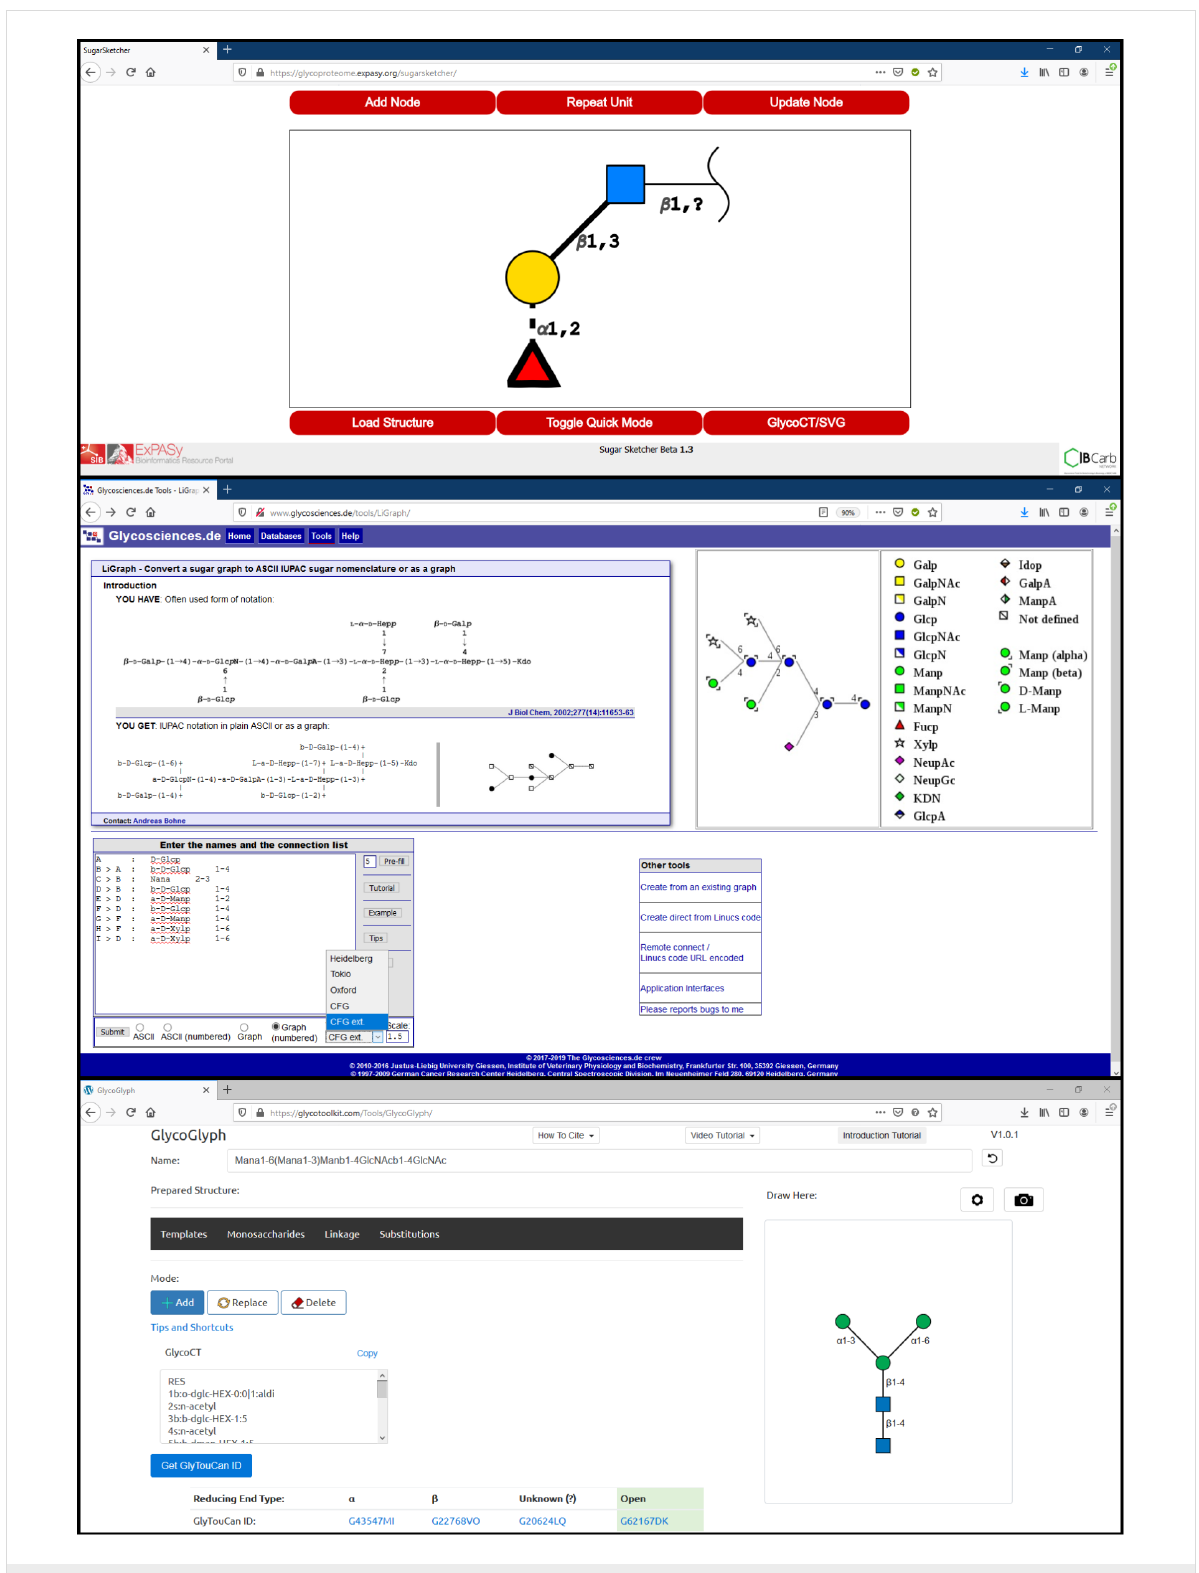
Figure 4: From top to bottom: SugarSketcher [36] interface with a glycan structure drawn using the “Quick Mode”. LiGraph interface showing input and output options for glycan structure representation. GlycoGlyph [37] interface with a text input (modified IUPAC condensed) converted into its glycan